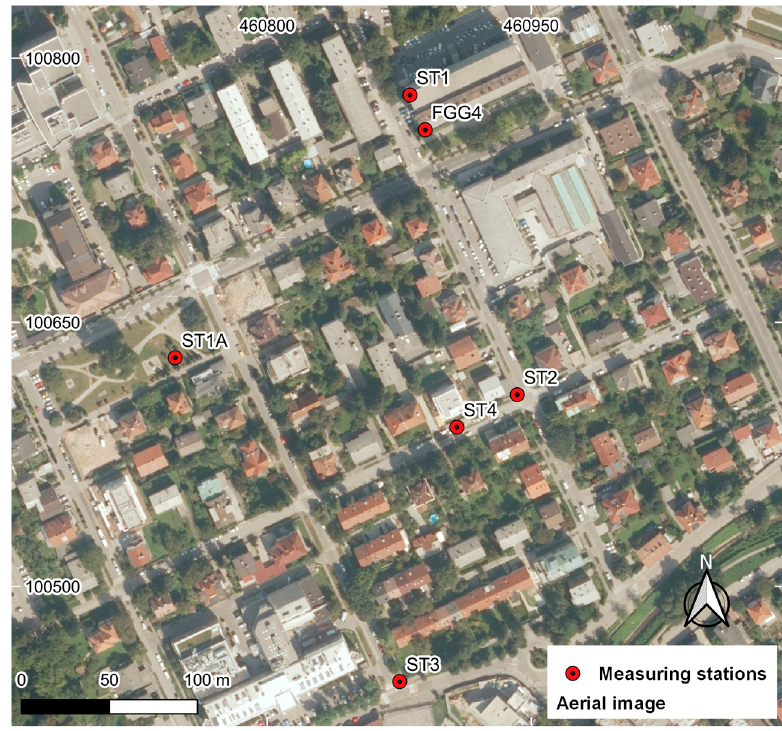
Figure 2. Measuring stations.